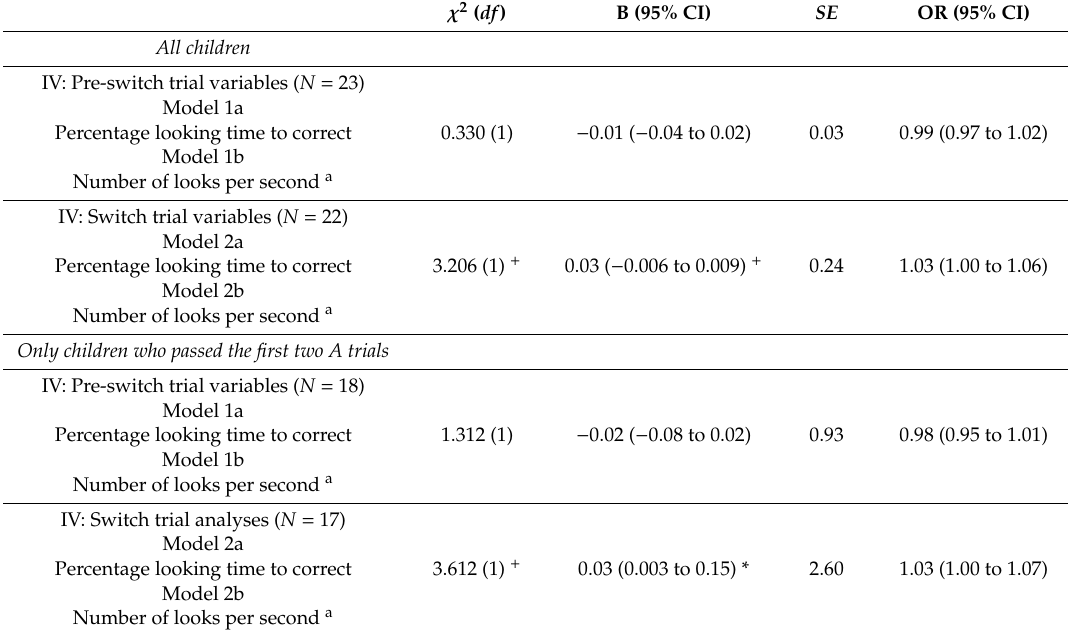
Table 3. Results of univariate logistic regression analyses predicting performance on the first switch trial by looking behavior.